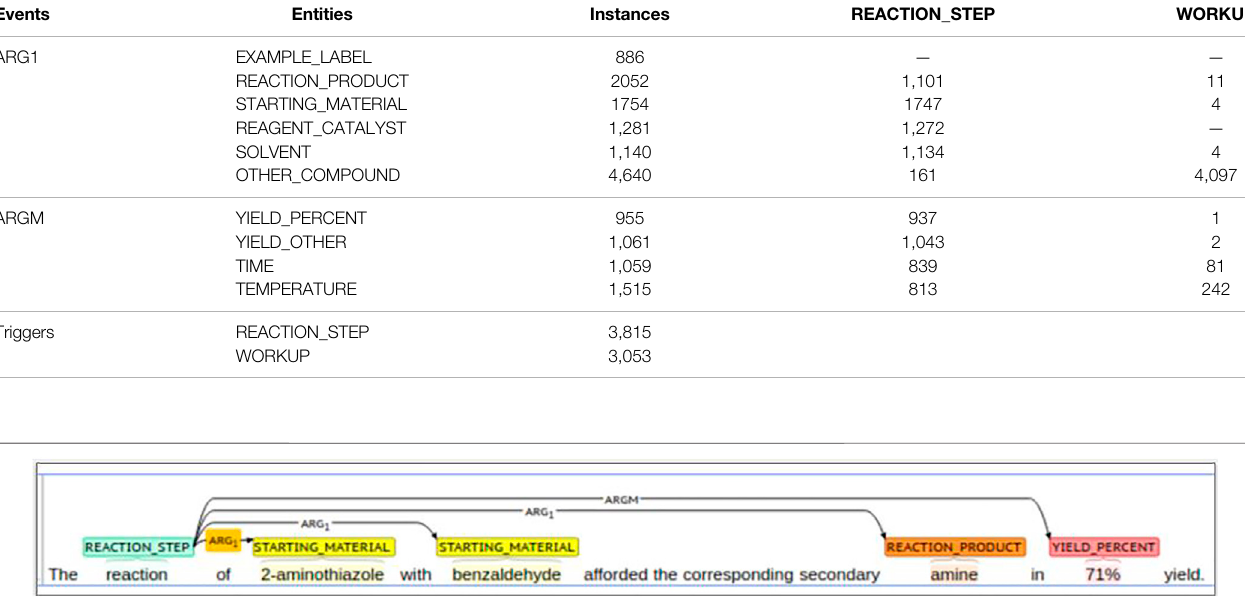
Frontiers in Research Metrics and Analytics |